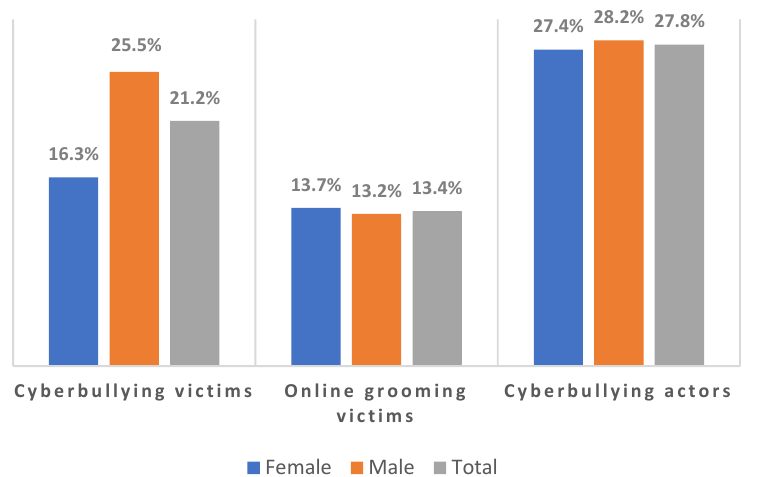
Figure 2. Prevalence rates of cyberbullying perpetration and victimisation and online grooming victimisation by sex.